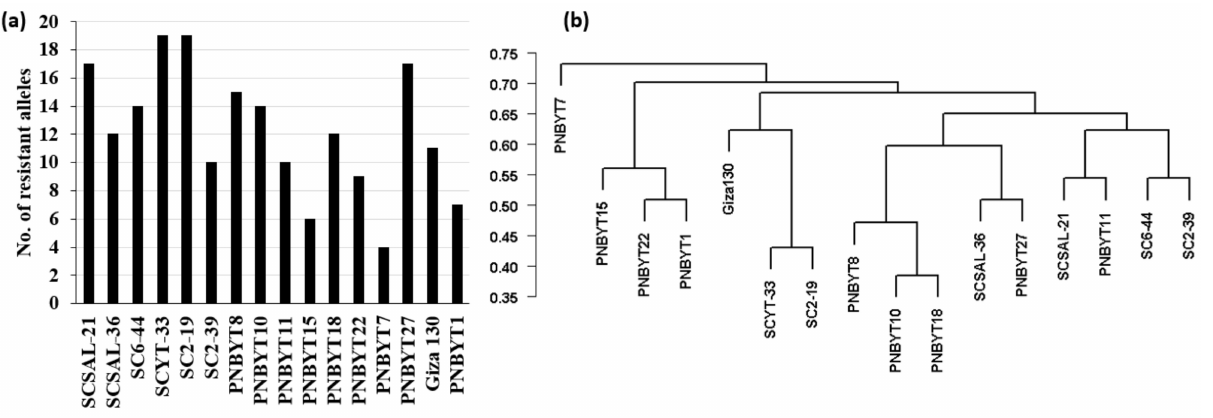
Figure 5. ( a ) number of resistant alleles in the most resistant genotypes and ( b ) genetic distance and dendrogram analyses among the most resistant genotypes based on the presence of resistance